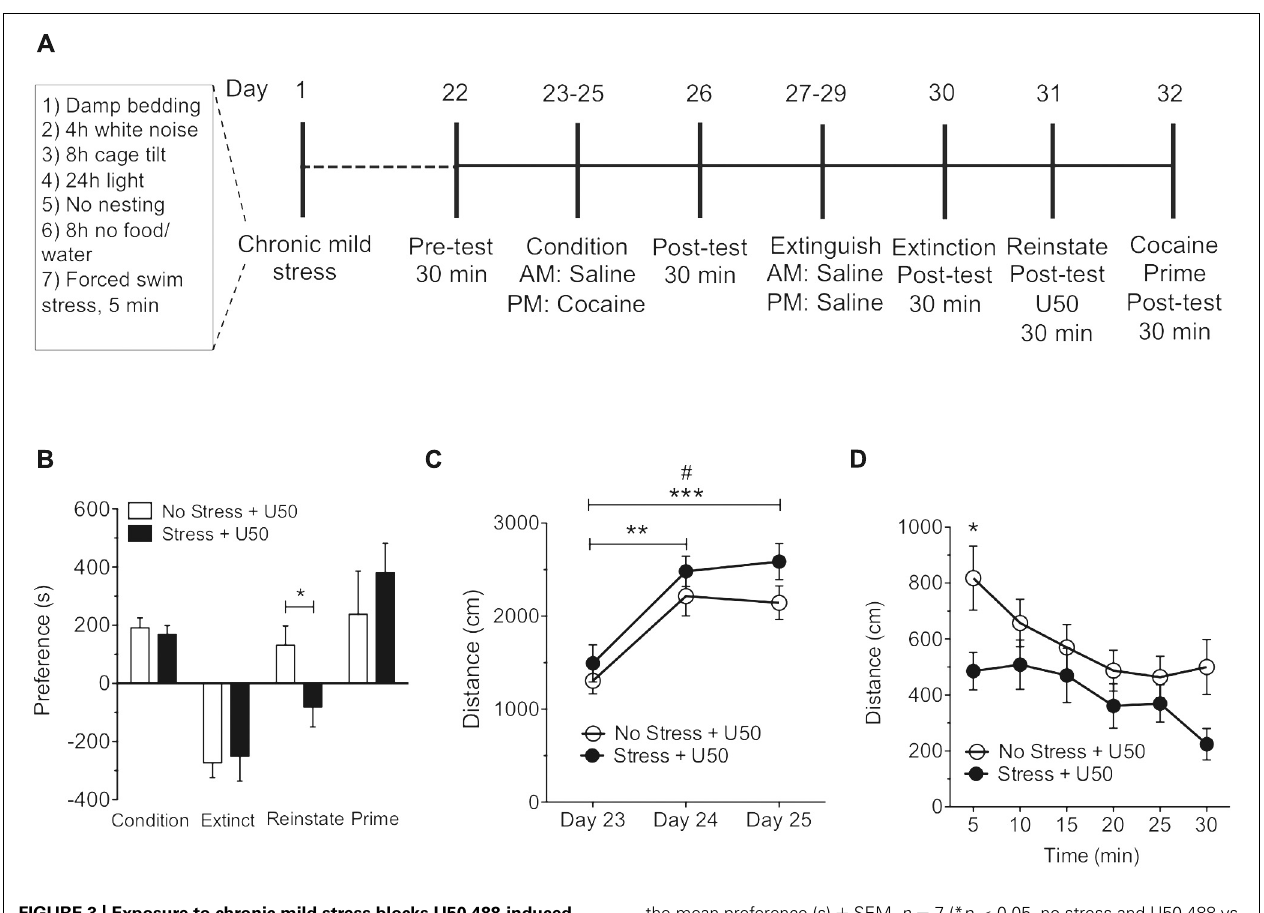
FIGURE 3 | Exposure to chronic mild stress blocks U50,488-induced but not cocaine-primed reinstatement of cocaine place preference. (A) Timeline of cocaine place preference-reinstatement experiment. (B) Cocaine preference scores (day 26), calculated as post-test minus pre-test on the cocaine-paired side (condition), U50,488-induced (5 mg/kg, i.p.) reinstatement scores (reinstate, day 31), or cocaine-induced (15 mg/kg, i.p) reinstatement (prime, day 32) of extinguished place preference. Data show a significant attenuation in U50,488-induced but not cocaine-primed reinstatement to cocaine seeking following chronic mild stress. Groups are defined in the figures as their final reinstatement grouping (U50 = U50,488).Data represent